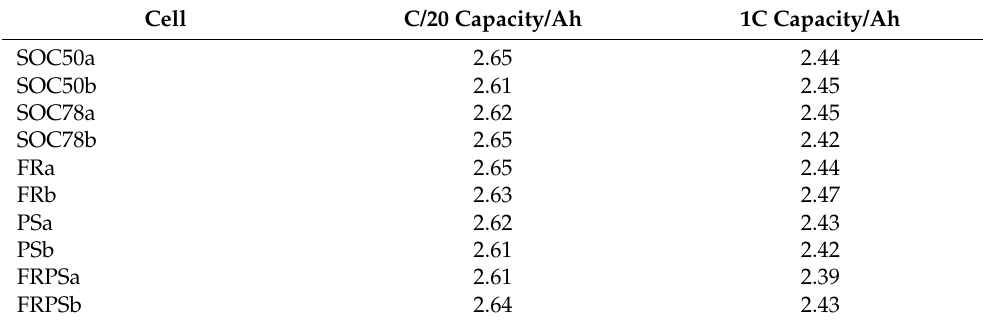
Table 2. Initial cell capacity.